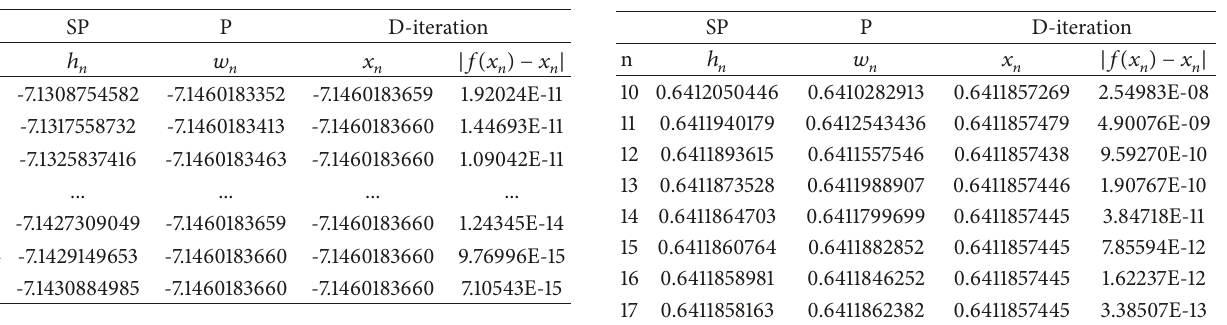
Table 6: The rate of convergence of SP-, P-, and D-iterations for 𝑓(𝑥) = (0.5) 𝑥 . SP P D-iteration n |𝑥 𝑛 −